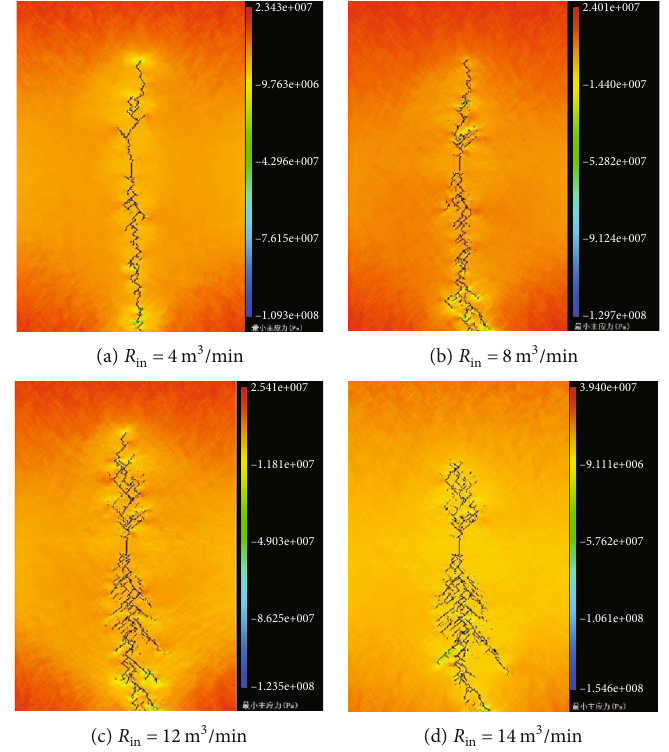
Figure 18: Hydraulic fracture propagation patterns under di ff erent injection